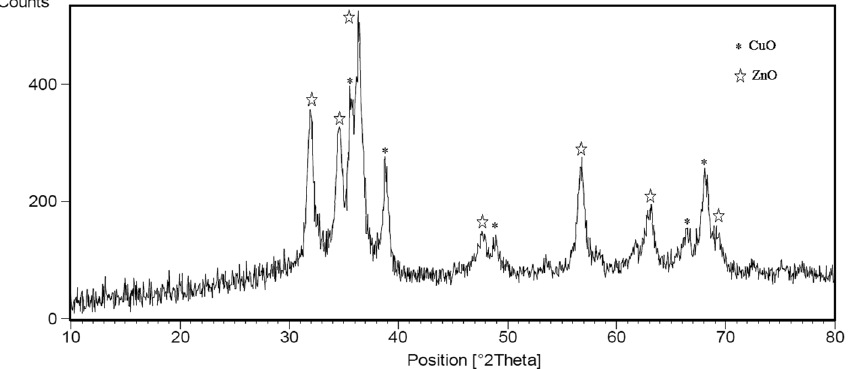
Figure 1. XRD spectrum of the bimetallic ZnO/CuO NPs.